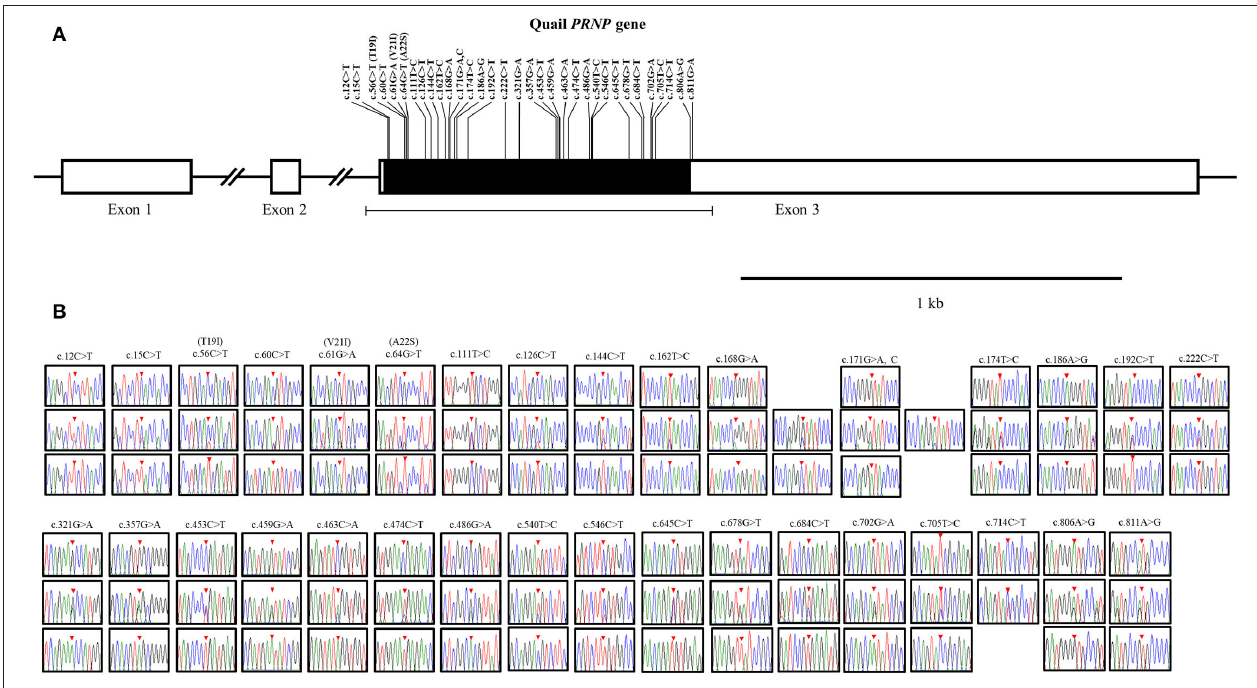
FIGURE 1 | Novel single nucleotide polymorphisms (SNPs) in the quail prion protein gene ( PRNP ) were found in this study. (A) Schematic map of the quail PRNP gene with SNPs. T19I, V21I, and A22S indicate three nonsynonymous SNPs. (B) Electropherograms of the 33 novel SNPs in the quail PRNP gene. The colors of the peaks indicate each base of the DNA sequence (green: adenine; red: thymine; blue: cytosine; and black: guanine). The red arrows indicate the location of the SNPs found in this